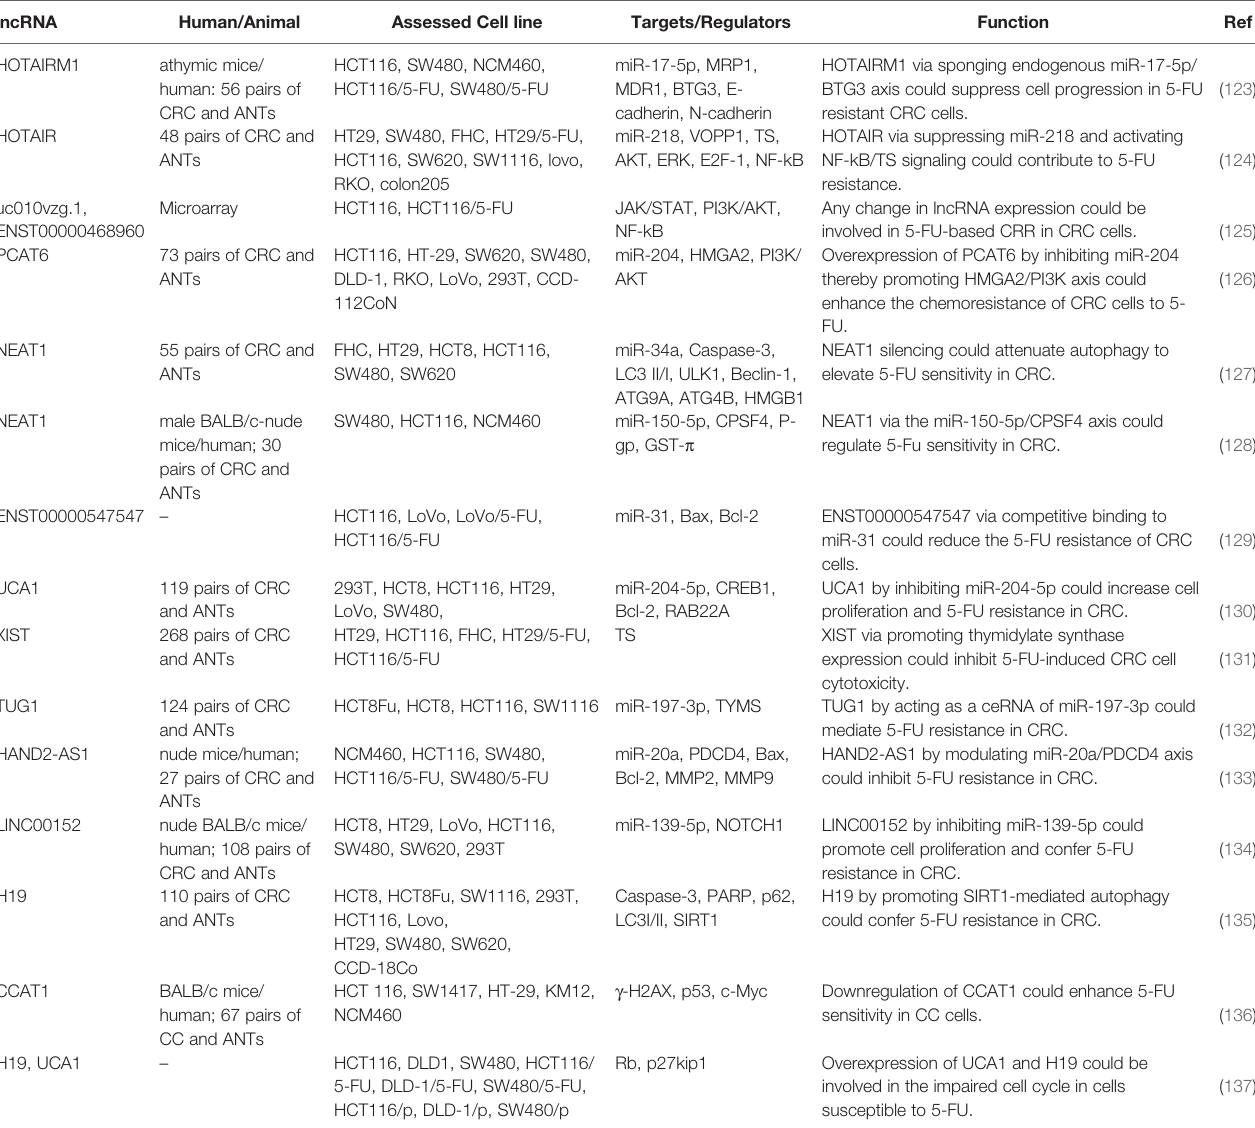
TABLE 6 | Role of lncRNAs in the modulation of response to 5-FU in colorectal cancer (ANT, adjacent normal tissue). lncRNA